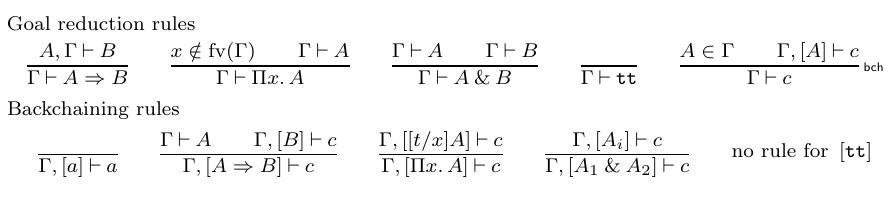
Fig. 2: The Inference System